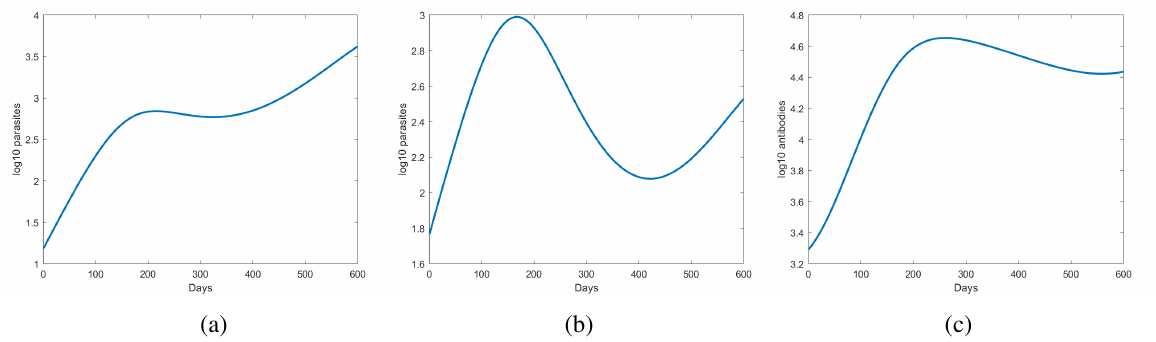
IgG antibody units. 10